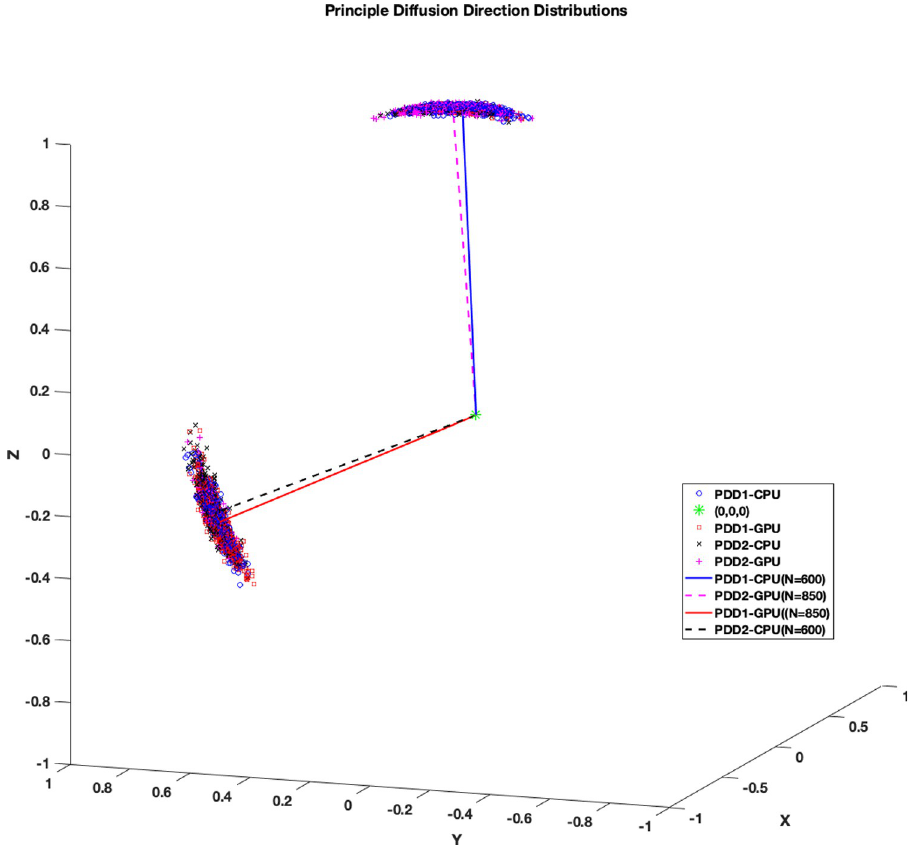
Fig 10. Distribution shape and diffusion directions of ϕ 1 and θ 1 . Example ϕ 1 , θ 1 and ϕ 2 , θ 2 principal diffusion direction distributions from a representative voxel plotted in 3D (Blue circle: CPU ϕ 1 , θ 1 samples, Red square: GPU ϕ 1 , θ 1 samples, Black x’s: CPU ϕ 2 , θ 2 samples, Magenta +’s: GPU ϕ 2 , θ 2 samples). Mean directions derived from each clusters with majority of samples are represented as line drawings (Blue solid line: CPU ϕ 1 , θ 1 mean direction, N = 600, Red solid line: GPU ϕ 1 , θ 1 mean direction, N = 850, Black dotted line: CPU ϕ 2 , θ 2 mean direction, N = 600, Magenta dotted line: GPU ϕ 2 , θ 2 mean direction, N =